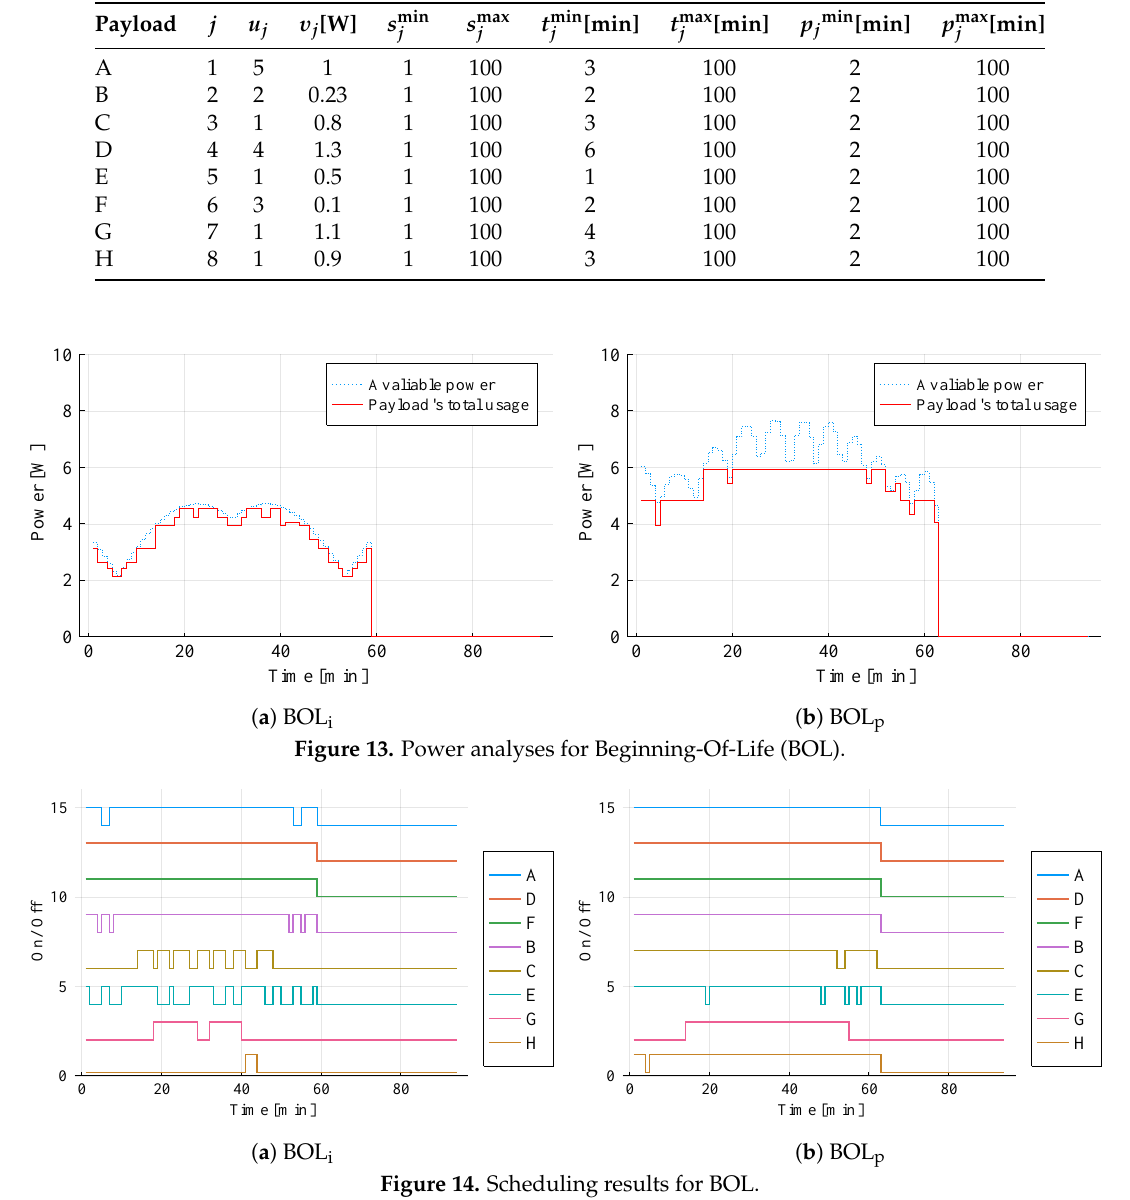
Figure 14. Scheduling results for